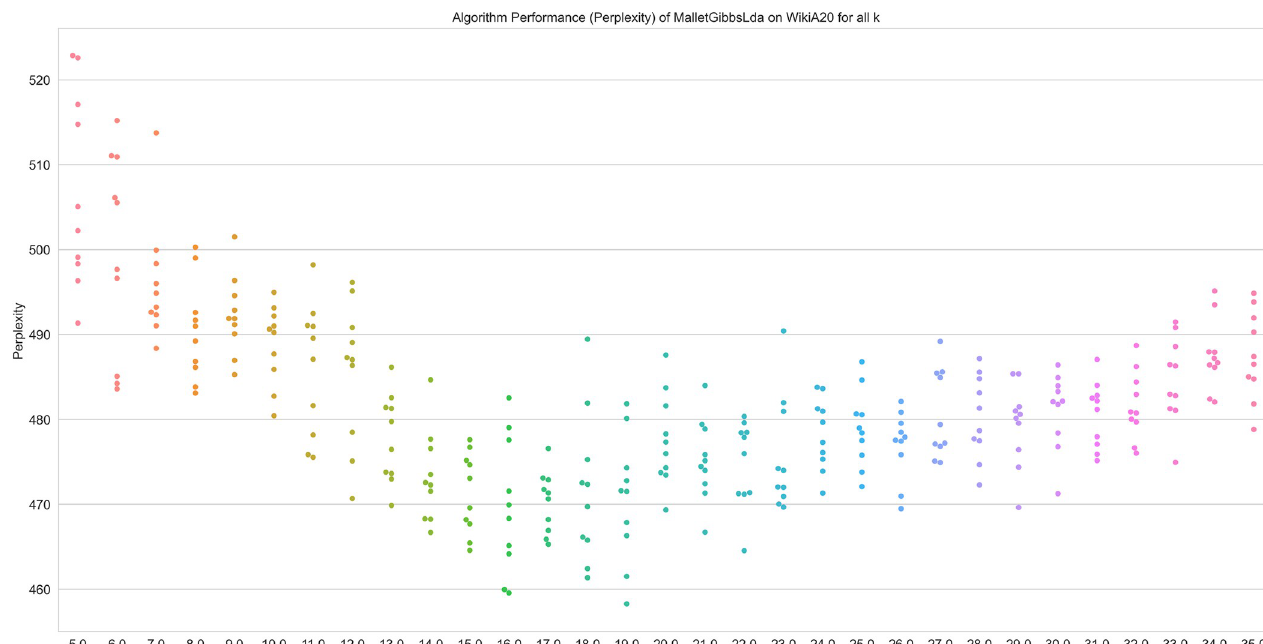
Fig 8. Algorithm performance (perplexity) of sampling-based LDA on the Wiki20 dataset.